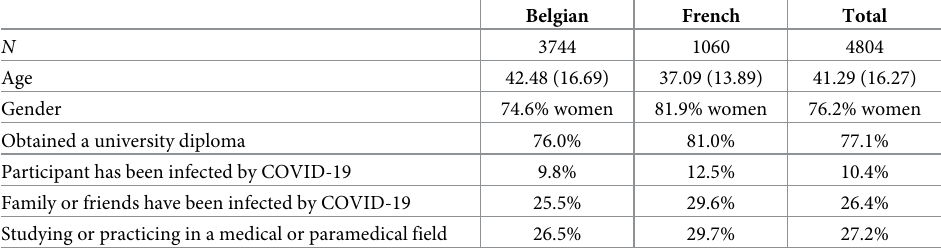
Table 1. Summary table of sociodemographic characteristics for Belgian and French